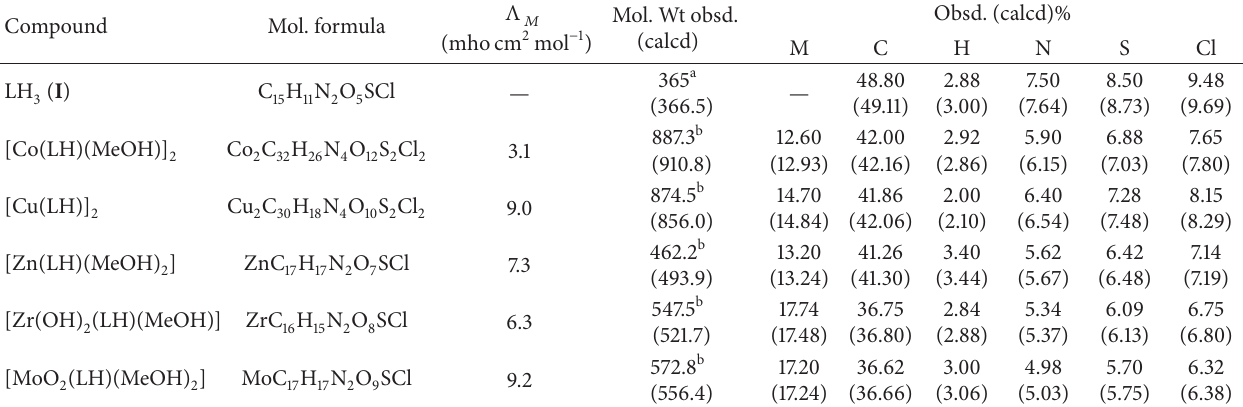
Table 1: Analytical, molar conductance ( Λ 𝑀 ) and molecular weight data of I and its coordination compounds.